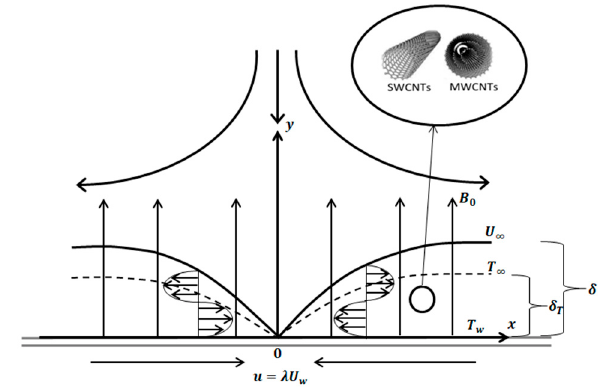
Figure 1. MHD stagnation flow of nanofluid past shrinking